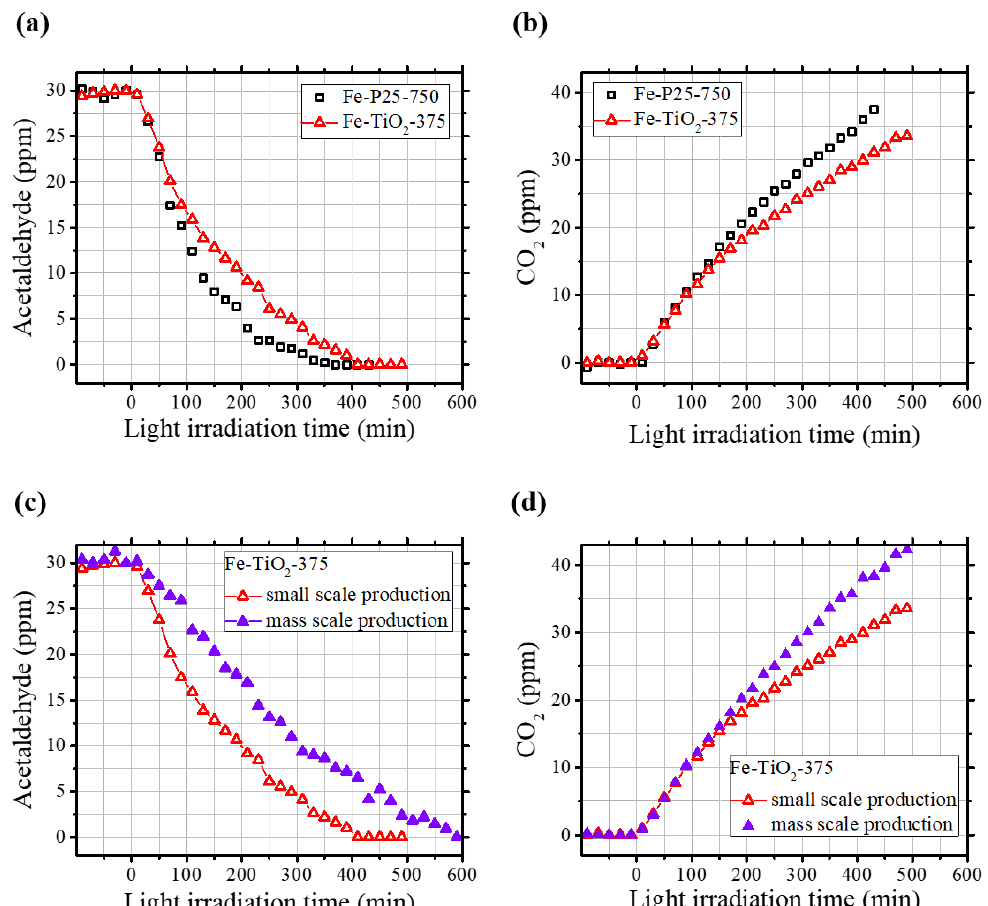
Figure 7. The results of the photocatalysis experiments (Fe-P25-750 and mass-produced Fe-TiO 2 -375). Concentration changes of ( a ) acetaldehyde and ( b ) CO 2 as a function of the visible light irradiation (Table 2) and Fe-P25-750 samples. Concentration changes of ( c ) acetaldehyde and ( d ) CO 2 as a function of the visible light irradiation time in the presence of Fe-TiO 2 -375 produced at small scale and mass-produced Fe-TiO 2 -375.